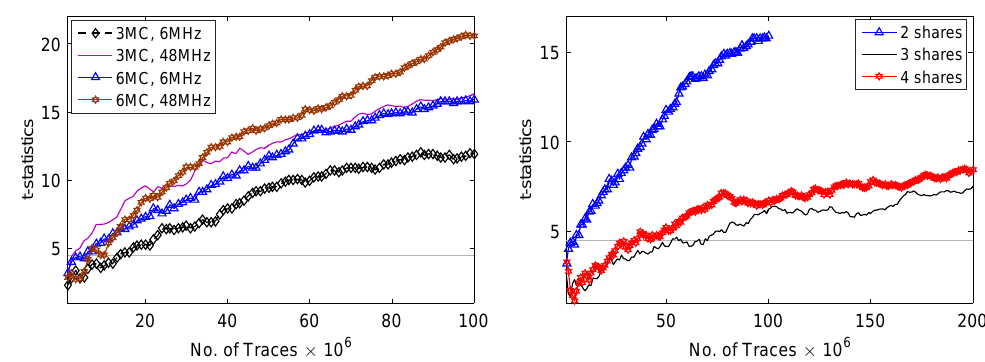
Figure 8: Case study 1: Vdd 1.3 v, shunt 0.0 Ω, room temperature, max ( | t | ) 1st-order, over the number of